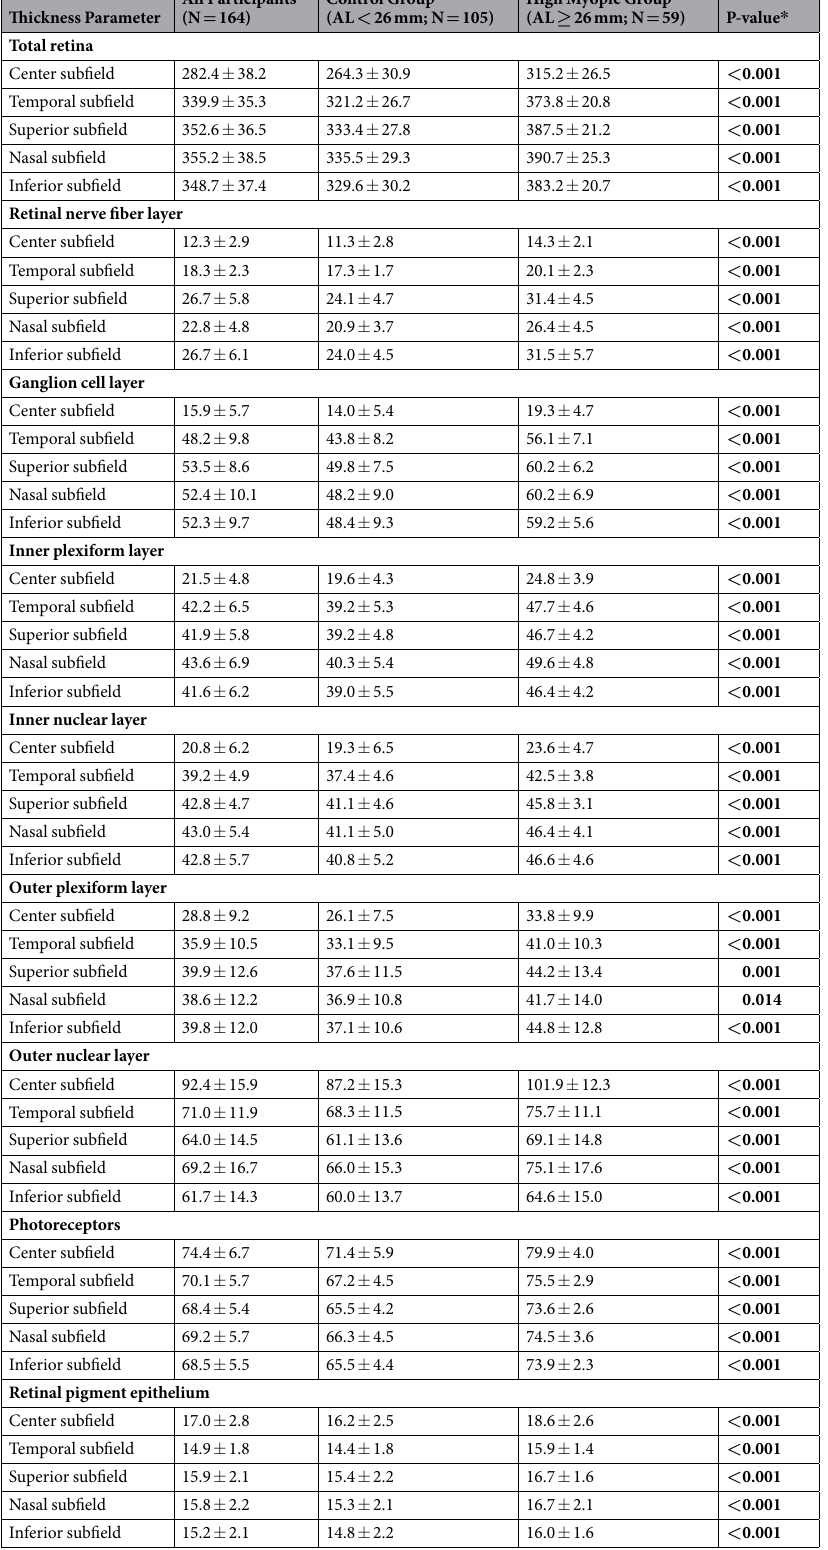
Table 2. Comparisons of individual retinal layer thickness in the foveal and 4 perifoveal region measured by the automated segmentation of the Spectralis optical coherence tomography after ocular magnification adjustment. AL, axial length. Values are presented as mean thickness ± standard deviation; SD ( µ m). P values were yielded by independent student t-test between the control group (AL < 26 mm) and high myopia group (AL ≥ 26 mm). * Bold values indicate statistically significant differences (P <